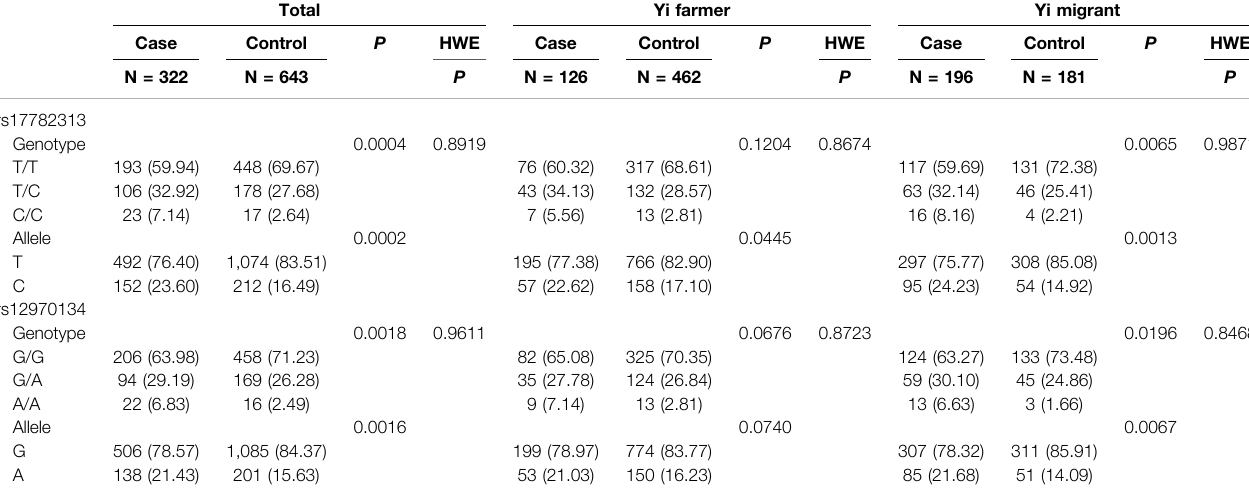
TABLE 2 | Comparison of genotype and allele frequencies and the HWE test between case and control groups in Yi people. Total Yi farmer Yi migrant Case Control P HWE Case Control P HWE Case Control P HWE